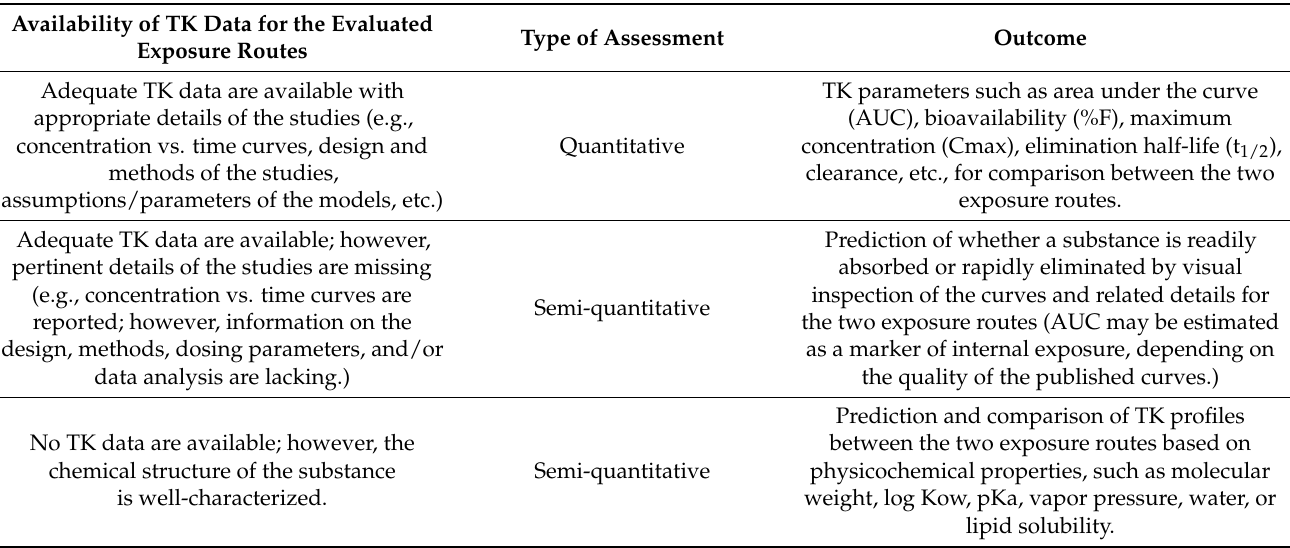
Table 1. Examining and comparing TK profiles of a substance between the evaluated exposure routes based on the availability of relevant TK